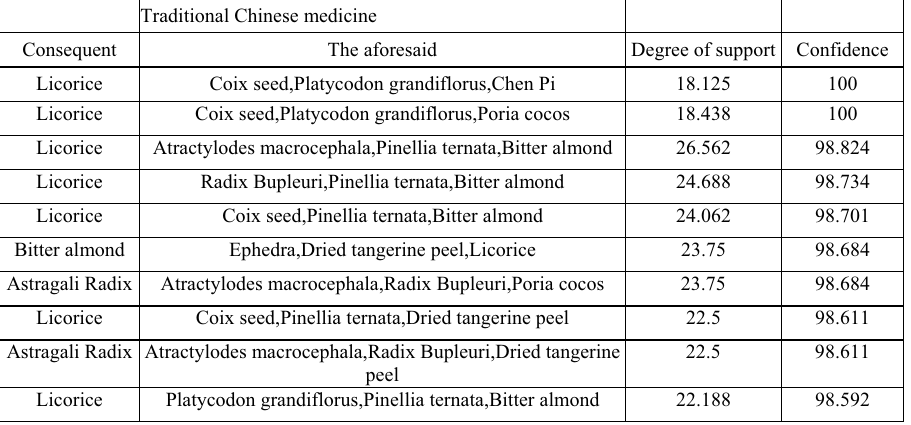
Table 4. Analysis of association rules of drug combinations in Chinese medicine against